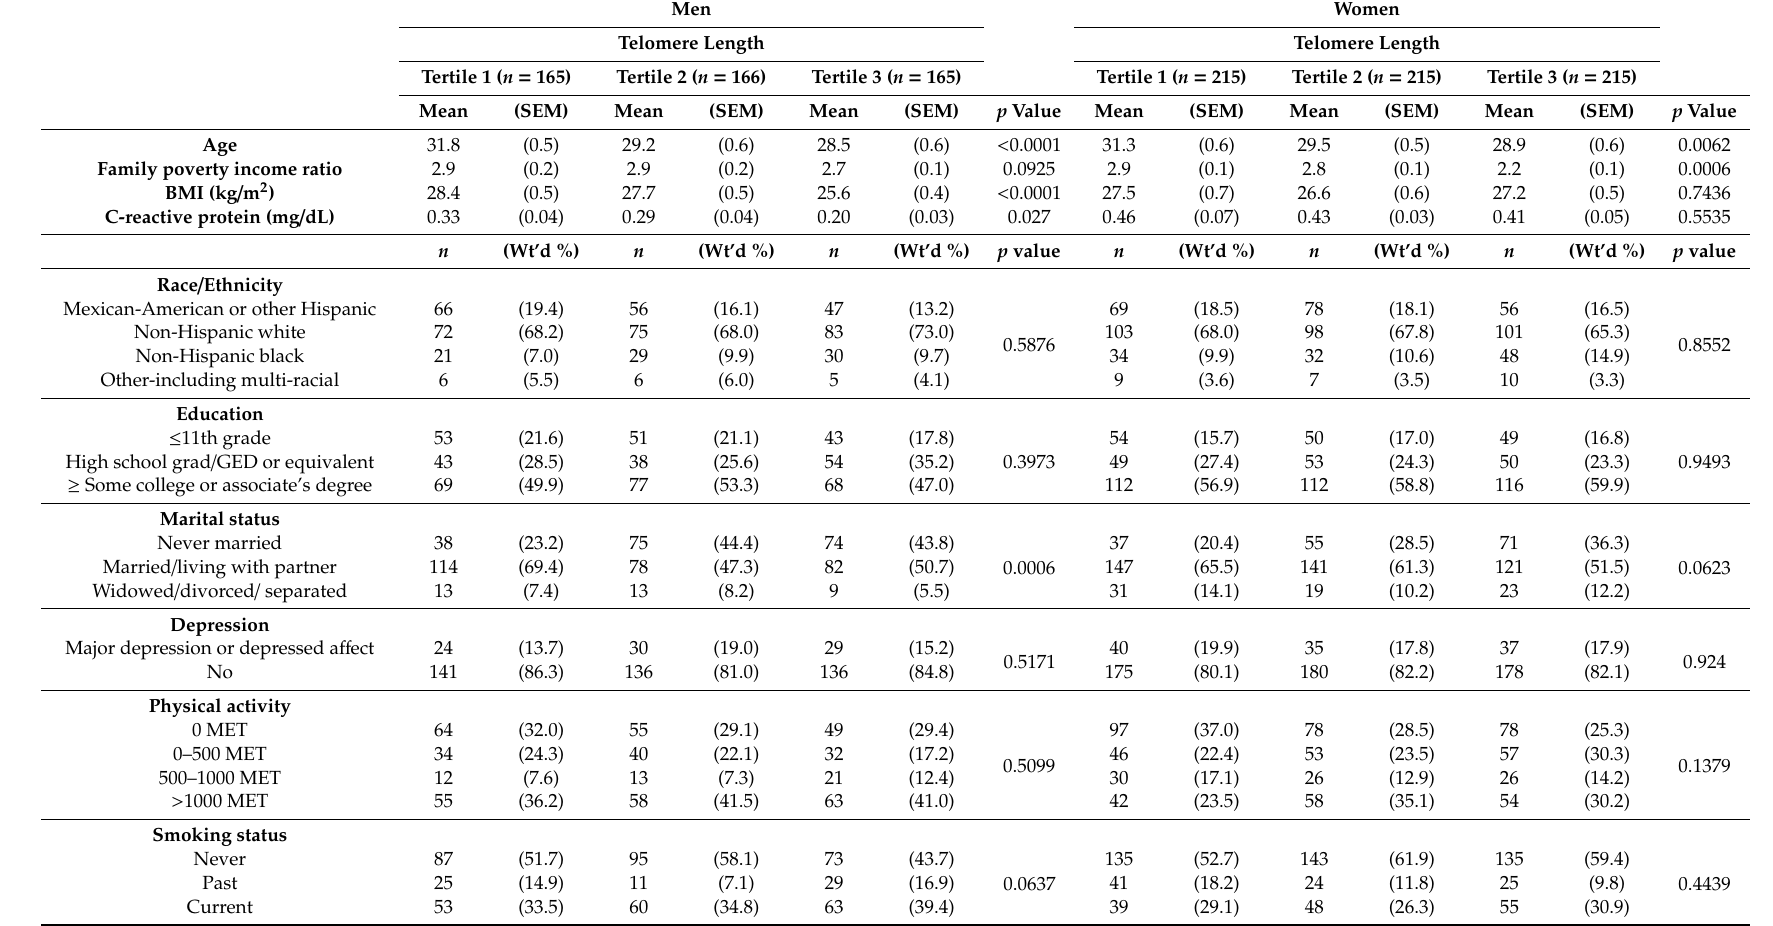
Table 1. Sociodemographic and lifestyle characteristics across the tertiles of telomere